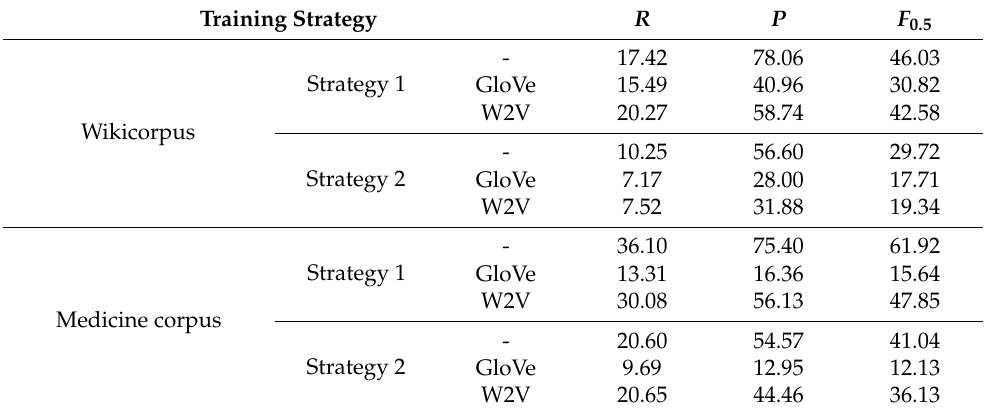
Table 13. Recall ( R ), precision ( P ) and F 0.5 for the evaluation of Hunspell-generated error correction.